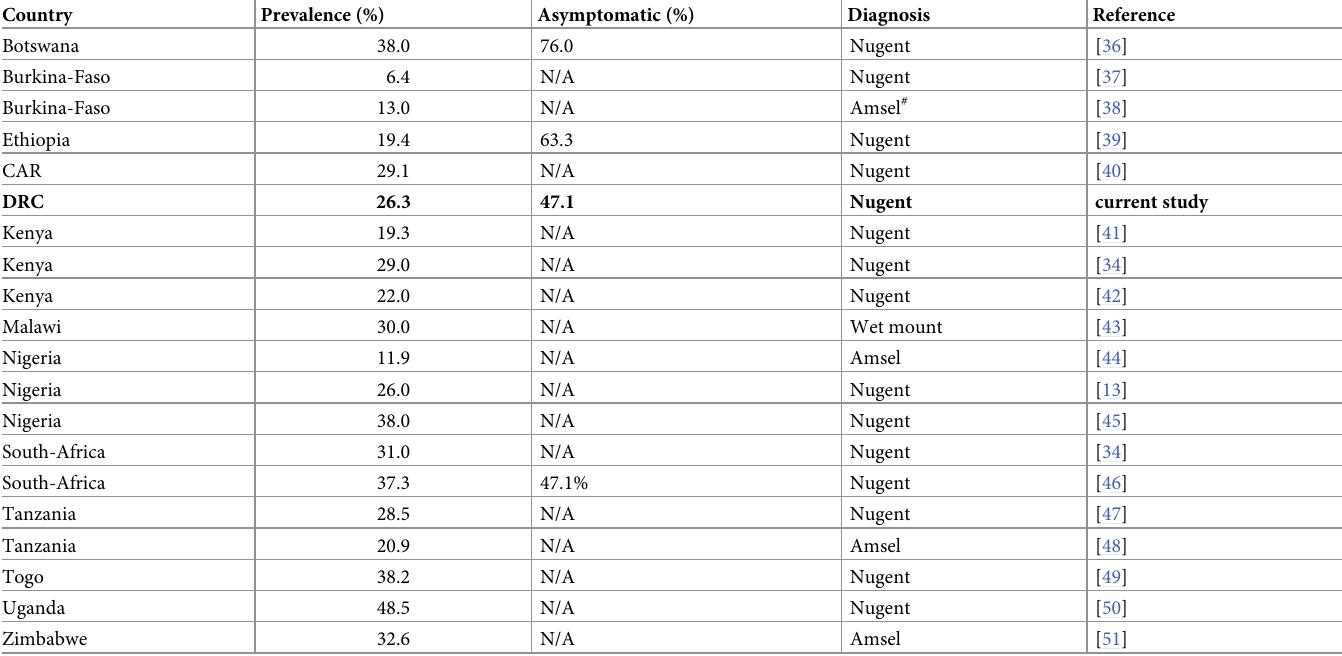
Table 6. Summary of studies reporting on the prevalence of BV in pregnant women from sub-Saharan Africa.